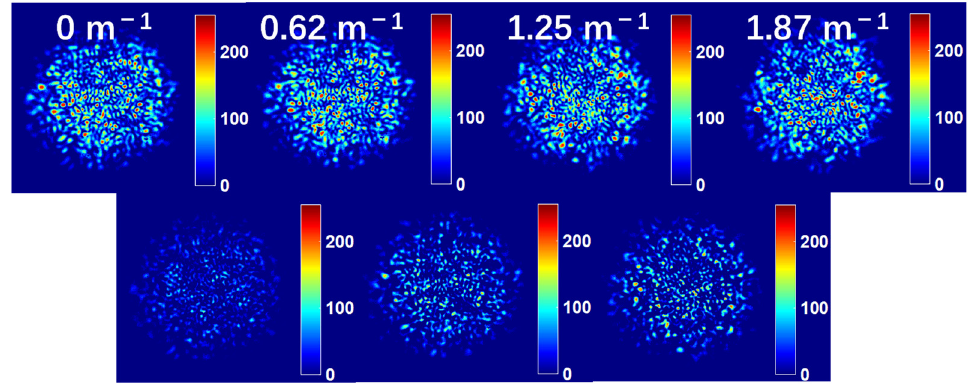
Figure 4. Speckle patterns corresponding to different curvatures collected from position P1 and their differences between the adjacent speckle patterns.